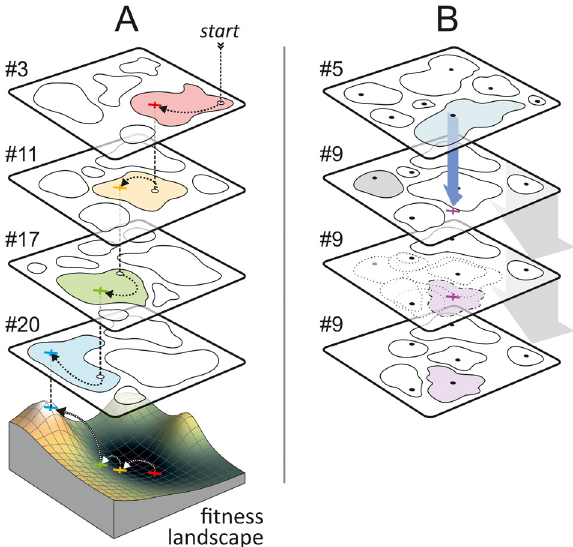
Figure 2. Schematics of attractor networks searching for the global optimum. A) Four time steps of selection, from top to bottom. At each step, we only show the network that produces the best output (numbered); the rest of the networks are not depicted. In each time step the networks are provoked by a new pattern that was selected from the previous generation of patterns. Different attractor networks partition the pattern-space differently: blobs inside networks represent basins of attraction. At start, the topmost network (#3) is provoked with an input pattern. It then returns the center of the attractor basin which is triggered by the input. When the output of this network is forwarded as input to the next network (#11), there is a chance that the new attractor basin has a center that is closer to the global optimum. If there is a continuity of overlapping attractor basins through the networks from the initial pattern (top) to the global optimum (bottom), then the system can find the global optimum even without learning. B) Learning in attractor networks . Network #5, when provoked, returns an output pattern that is used to train network #9 (blue arrow). As the network learns the new pattern, the palimpsest memory discards an earlier attractor (with the gray basin), a new basin (purple shape) forms around the new prototype (purple ×) and possibly many other basins are modified (basins with dotted outlines). Black dots indicate attractor prototypes ( i.e. learnt patterns). With learning, successful patterns could spread in the population of networks. Furthermore, if the transmission of patterns between networks is noisy a network might learn a slightly different version of the pattern, new variation is introduced to the system above and beyond the standing variation. This allows the system to find the global optimum even if it was not used to pre-train any network. The gray arrow in the background indicates the timeline of network